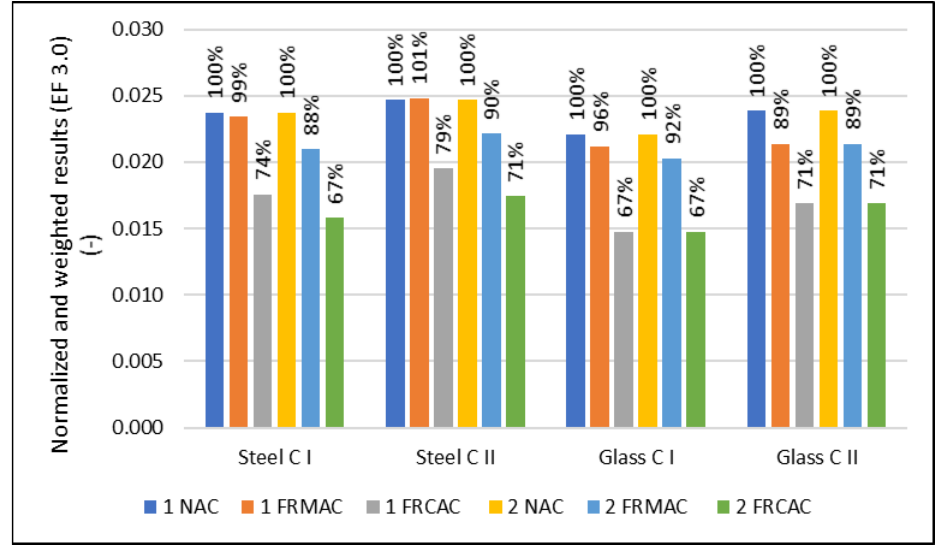
Figure 2. Normalized and weighted results for load-bearing capacity-oriented design scenarios (according to EF 3.0). Table 7. Normalized and weighted results (EF 3.0) and differences − ∆ (%) of limit state of load- bearing capacity (LB).